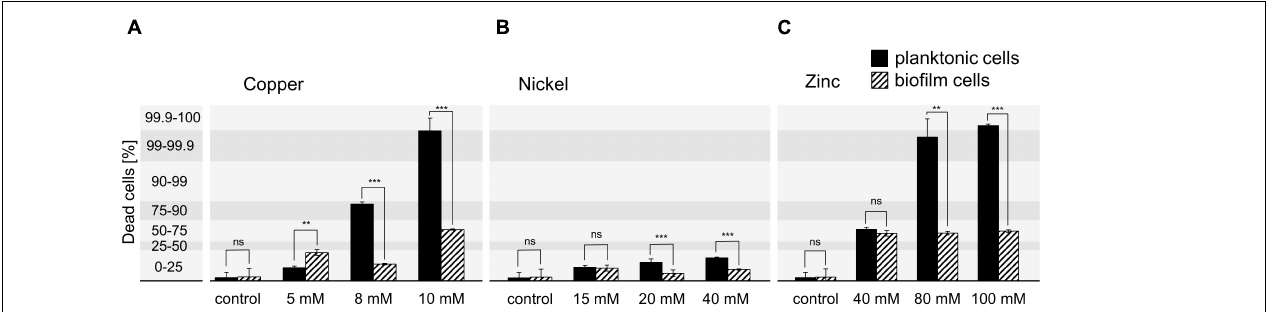
FIGURE 2 | Quantification of dead H. salinarum cells after metal treatment. Planktonic cells (OD 600 0.3) and 13 days biofilms were incubated with growth inhibiting concentrations of (A) copper, (B) nickel, or (C) zinc ions for 24 h. The percentage of dead cells was quantified by PMA-qPCR and compared to standard (cid:49) C T values corresponding to defined amounts of dead cells. Untreated cells were used as control. The significance of the data from planktonic compared to biofilm samples was assessed by t -test (ns, not significant, ∗ significant = P < 0.05, ∗∗ highly significant = P < 0.01, ∗∗∗ extremely significant = P < 0.001). The effect of the highest tested heavy metal concentrations was also investigated by confocal microscopy ( Figures 3 , 4